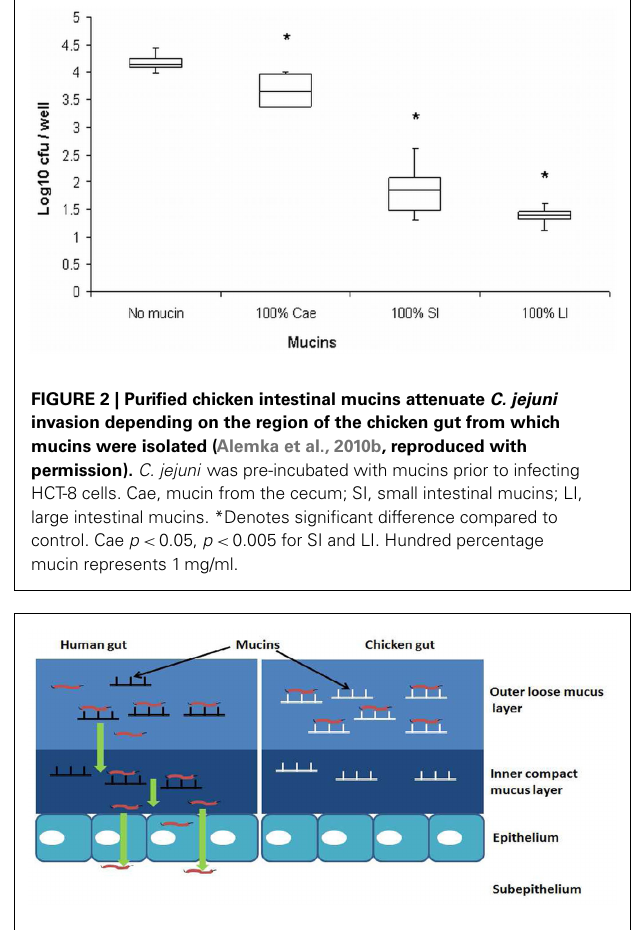
FIGURE 3 | Hypothetical model of how mucus and mucins modulate the pathogenicity of C. jejuni in a species-specific manner: in mucus C. jejuni displays chemotaxis and flagellar motility toward components of mucin.The characteristic spiral shape and the ability of C. jejuni to replicate in mucus suggests an adaptation of these bacteria to the mucus milieu. Interaction with human mucin enhances bacterial binding and internalization into underlying epithelial cells. In chickens, mucin glycoproteins prevent C. jejuni association with intestinal epithelial cells, possibly by interfering with their transit through the inner mucus layer and/or onto the appropriate host cell